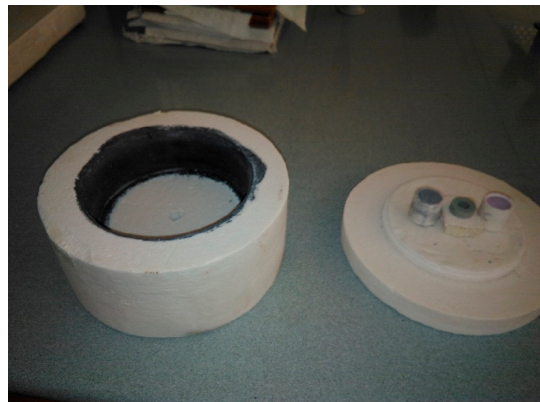
Figure 1. Capsule for microwave kiln painted with